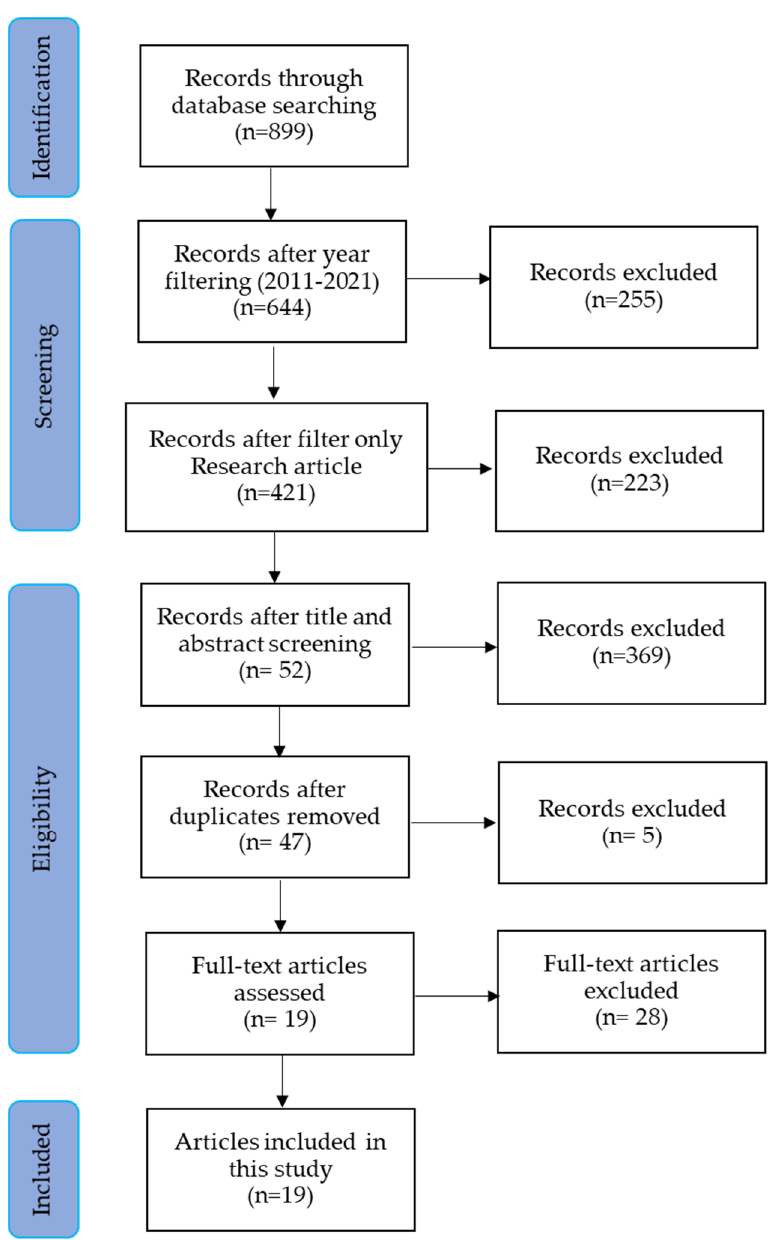
Figure 1. Document selection based on PRISMA workflow.